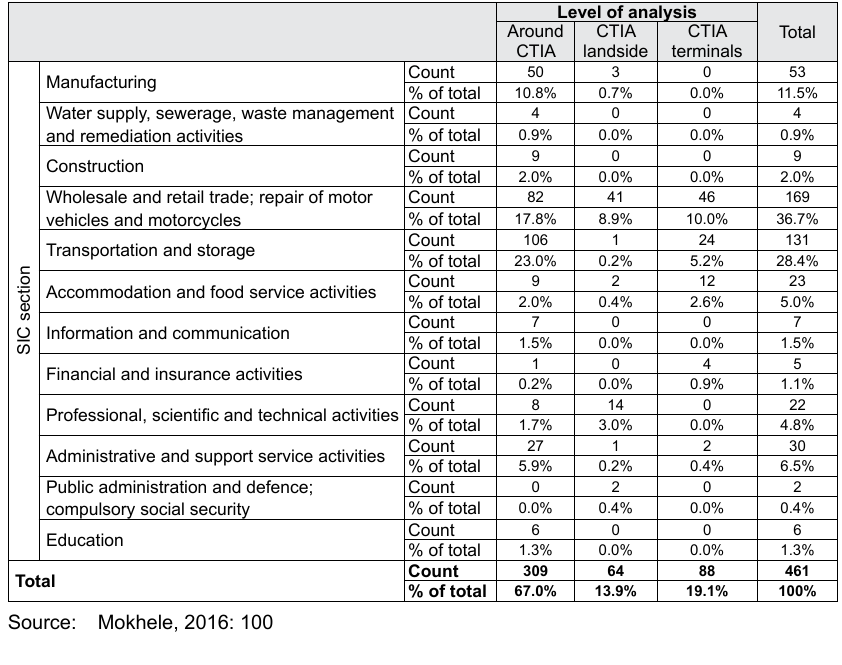
Mix of Cape Town airport-centric development